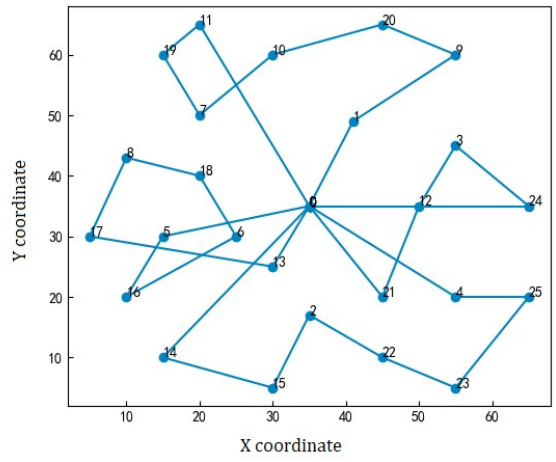
Figure 7. Optimal distribution roadmap in the comparison experiment.